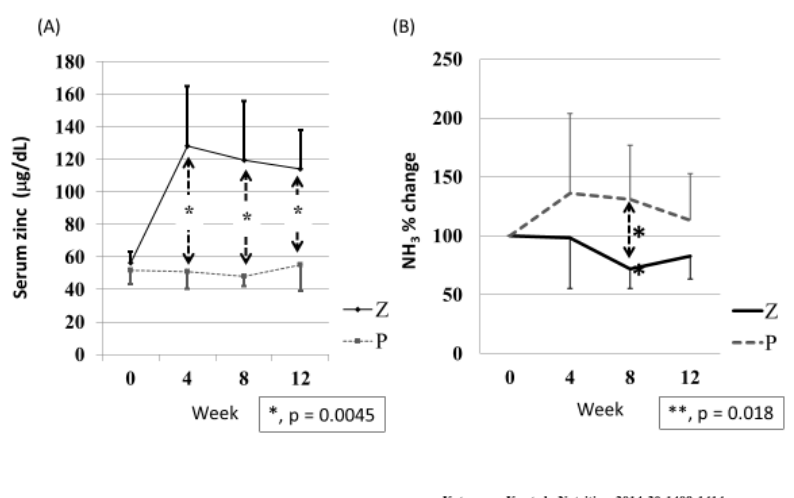
Figure 8. The e ff ect of zinc supplementation on serum ammonia levels in patients with liver cirrhosis. Cited from Katayama et al. [54]. Twelve patients with liver cirrhosis, hyperammonemia, and hypozincemia were randomly assigned to receive either zinc supplementation or a placebo. Z = zinc supplementation; P = placebo. ( A ) Serum zinc levels of patients in the Z group rose significantly ( p = 0.0037, Friedman test) during the trial, whereas those in the P group did not change significantly ( p = 0.4402, Friedman test). Intergroup di ff erences were significant by Mann-Whitney test at week 4, 8 and 12.; ( B ) Relative serum ammonia levels of patients in the Z group fell significantly ( p = 0.0114, Friedman test), whereas those in the P group did not ( p = 0.4717, Friedman test). The mean value of